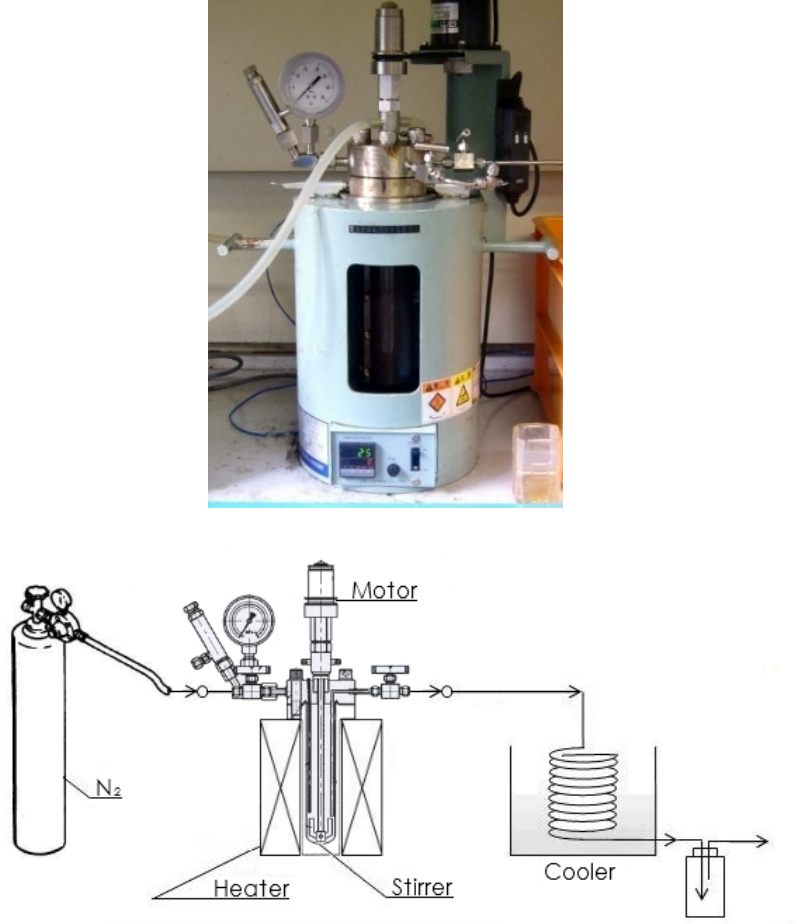
Figure 2. Laboratory-scale hydrothermal treatment of KOH-added